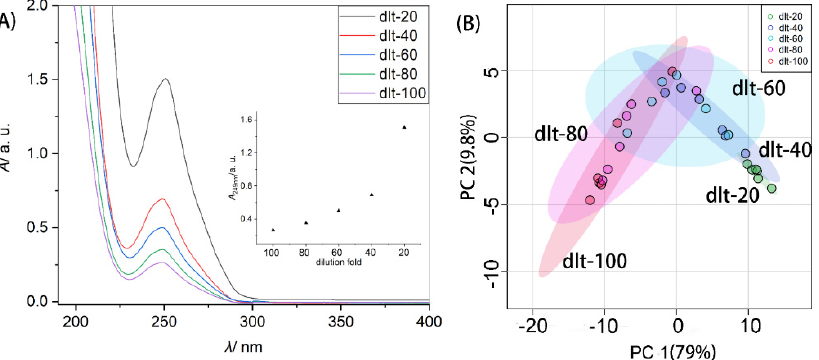
Figure 1. ( A ) UV-Vis spectra of extracts from 2 g of fish fillet sample of Scomberomorus niphonius (SN) with dilution folds of 20, 40, 60, 80 and 100 with deionized (DI) water. Inset is the plot of absorbance of solution of muscle extract at 249 nm versus dilution fold. ( B ) Plot of principal component analysis (PCA) scores for the UV-Vis spectroscopic results of tissue extracts of different concentrations of extract from fish, SN. The extraction was conducted following the protocol detailed in experimental Section 3.2. That is, the initial extract of fish muscle sample was obtained by pre-treating 2 g of fish muscle tissue sample with 10 mL of trifluoroacetic acid (TFA) aqueous solution (0.1%, v/v ), and diluted 20, 40, 60, 80 and 100-fold respectively with DI water for UV-Vis spectroscopic analysis.